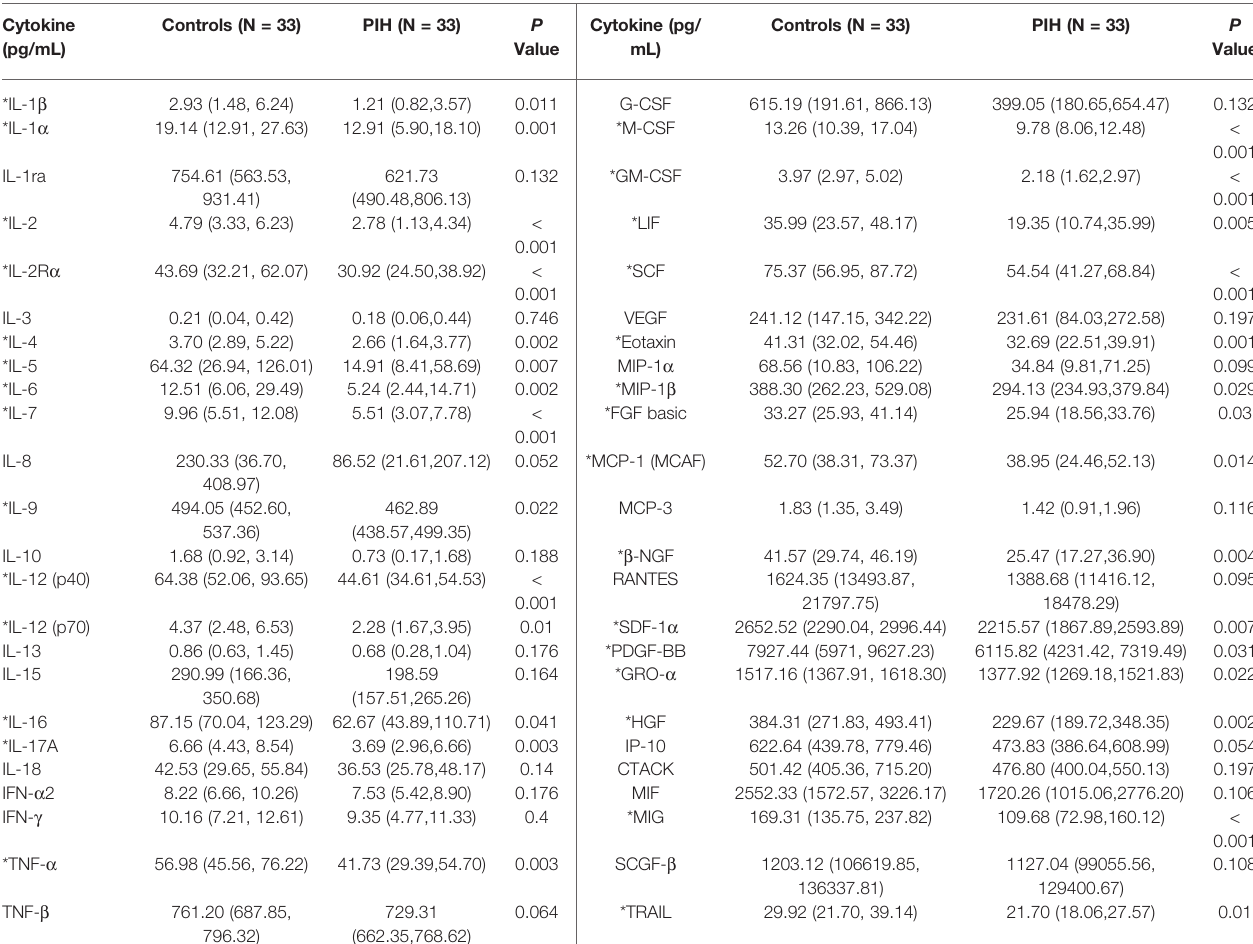
TABLE 3 | Cytokine pro fi le in fi rst-trimester serum in ART pregnancy. Cytokine